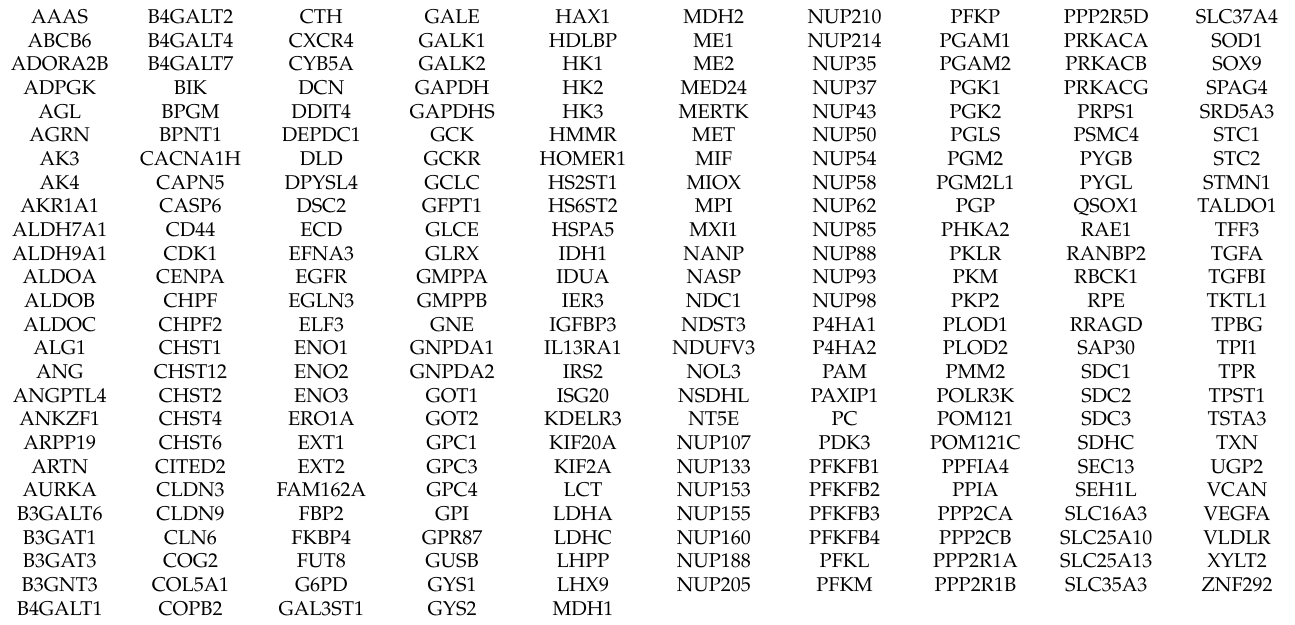
Table 1. The core genes screened out from 2 glycolysis-related pathways.